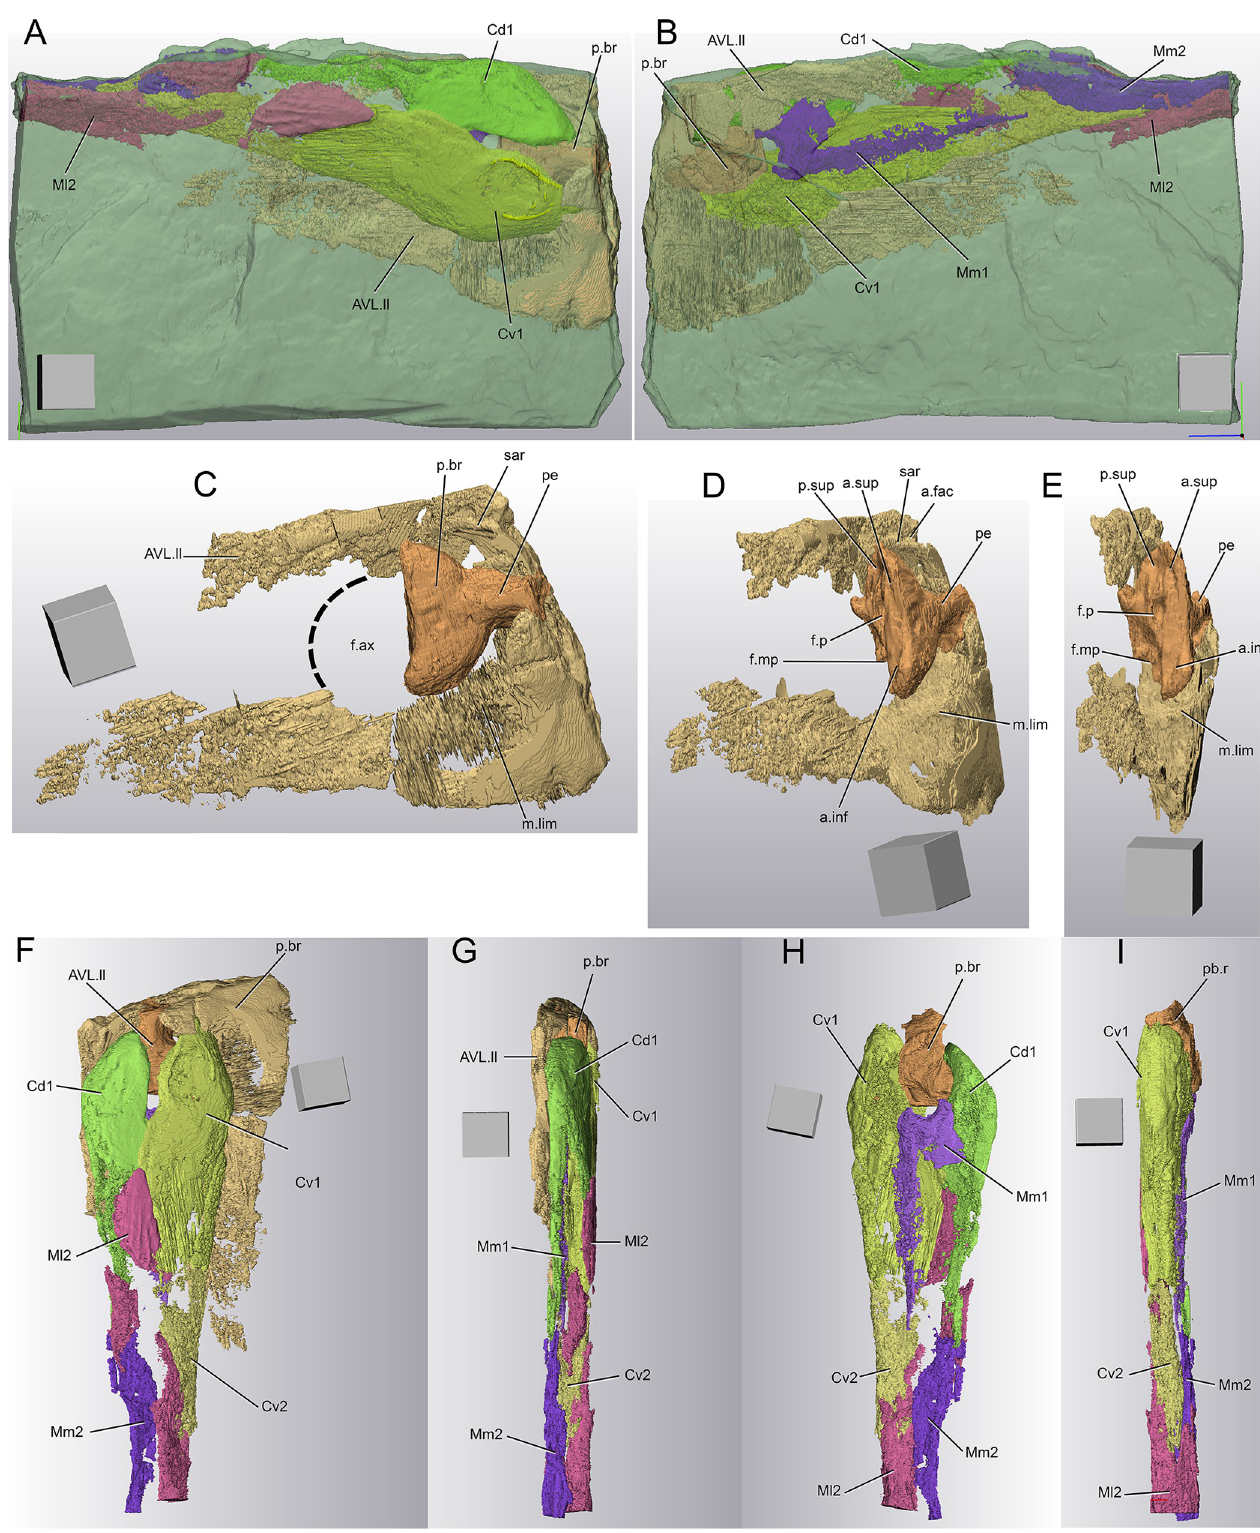
Fig 7. Bothriolepis dairbhrensis sp. nov. Digital rendering of an incomplete right pectoral fin, NMING:F35216 (images generated with Materialise 3-matic 13.0). A-B. Complete specimen with matrix semi-transparent (A, lateral view; B, median view). C-E. Lateral lamina of the anterior ventrolateral plate and